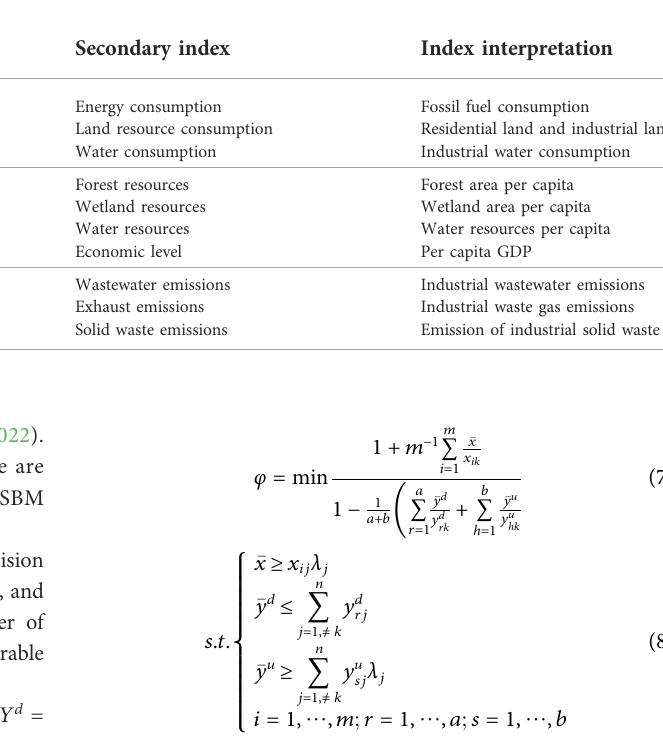
TABLE 3 Ecological performance index calculation